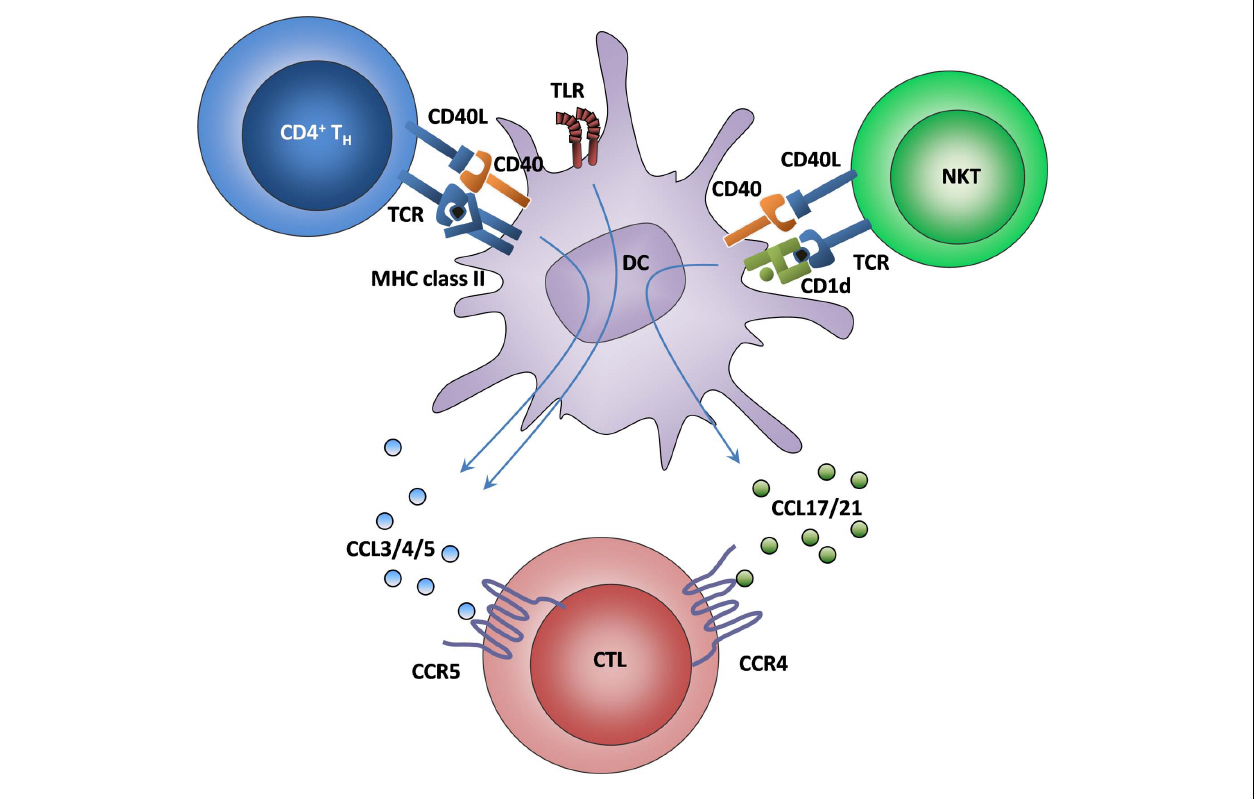
systems, DCs are rendered even more attractive to CTLs, which leads to an increased exploitation of the few antigen-specific CTLs from the precursor pool. How CCR4 and CCR5 are upregulated on naïve CTL is currently